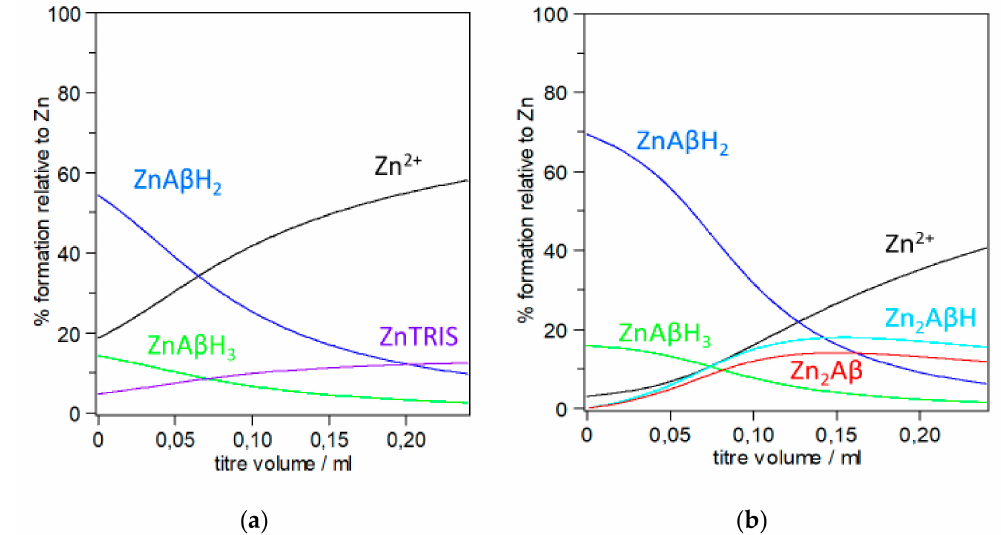
Figure 2. Computed species distribution reproducing the addition of Zn 2 + to A β (1–16)PEG in 20 mM TRIS bu ff er, 100 mM NaCl, pH 7.4, t = 25 ◦ C; ( a ) C Zn = 5 × 10 − 4 , C A β = 20 µ M; Zn 2 + (black line), ZnA β H 3 (green line), ZnA β H 2 (blue line), ZnTRIS (fuchsia line); ( b ) C Zn = 3 × 10 − 3 M, C A β = 140 µ M; free Zn 2 + (black line), ZnA β H 3 (green line), ZnA β H 2 (blue line), Zn 2 A β H (turquoise line), Zn 2 A β (red line). A β (1–16)PEG protonation constants from [37]; TRIS protonation and Zinc-TRIS formation constants and Zn 2 + hydrolysis constants from [96]. Species percentage was computed by using HYSS